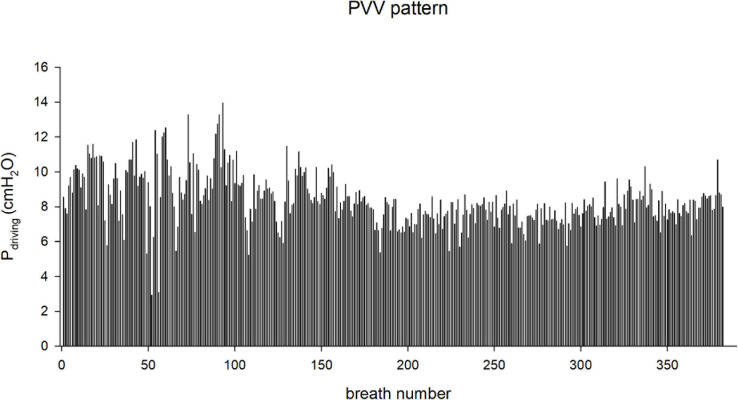
Changes in the driving pressure (Pdriving) during the application of physiological variable ventilation (PVV) pattern, in a representative rabbit.